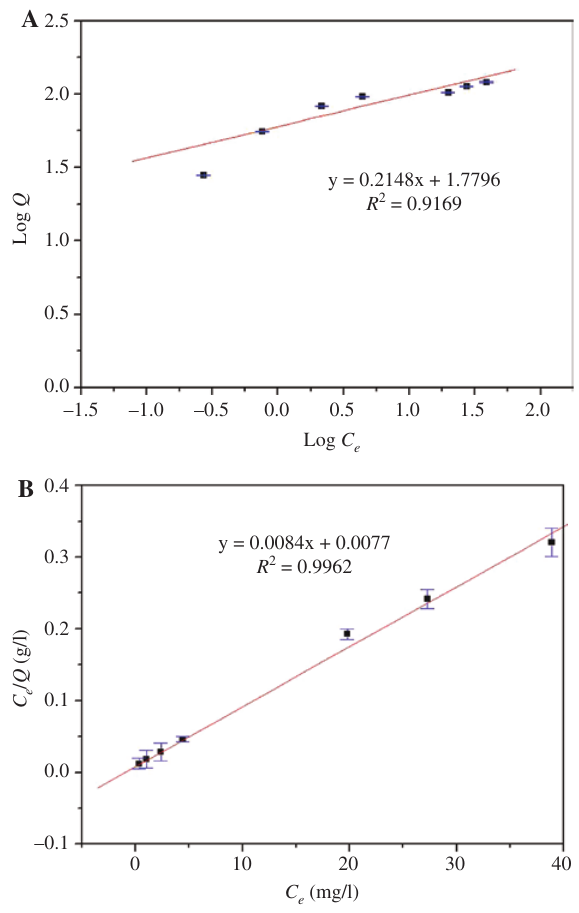
Figure 4: (A) Freundlich and (B) Langmuir adsorption isotherms for Cd 2 + sorption by HAp powder.